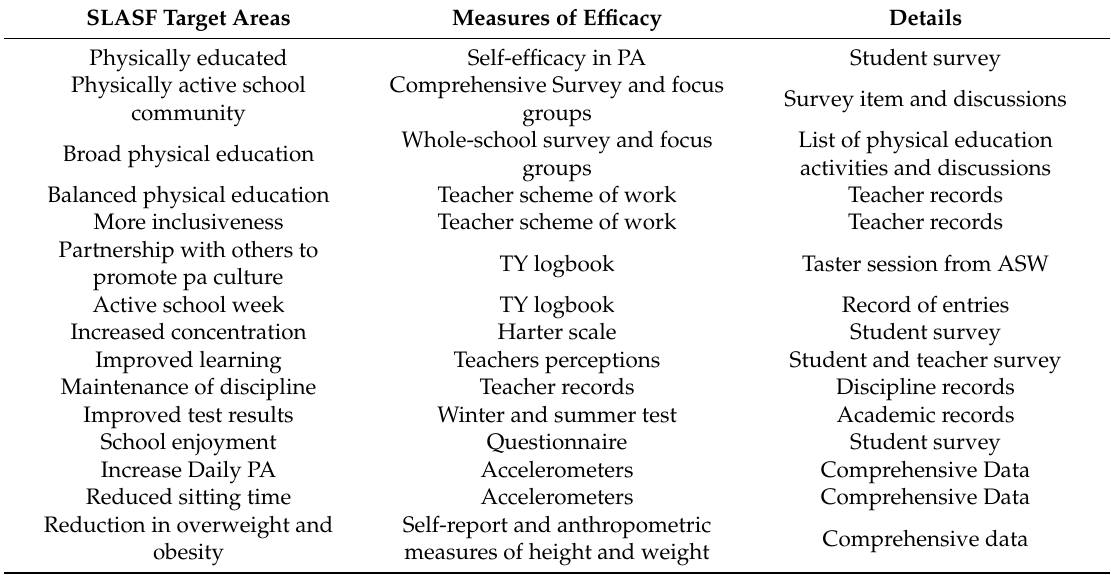
Table 2. Aligning outcomes with